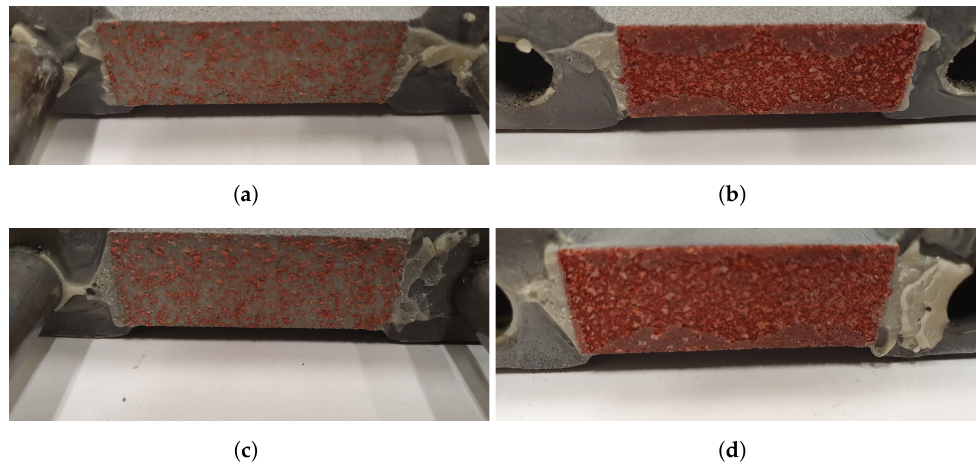
Figure 12. The fractured cores of two specimens, subjected to LC 1, are presented. ( a , c ) contain the lower skins and ( b , d ) contain the upper